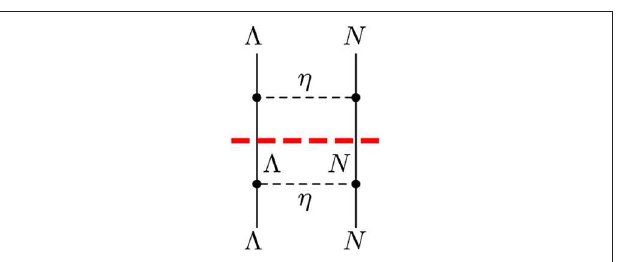
symmetry breaking 3 χ is often estimated as 4 π f π